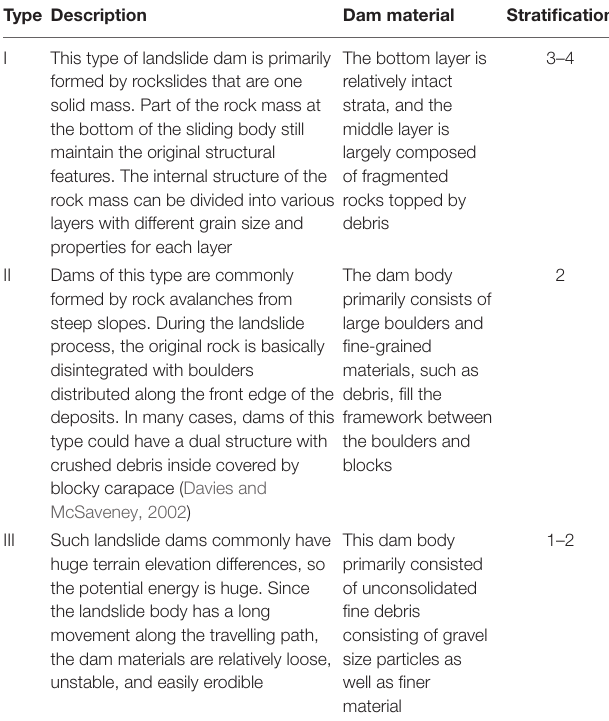
TABLE 2 | Simplified landslide dam classification